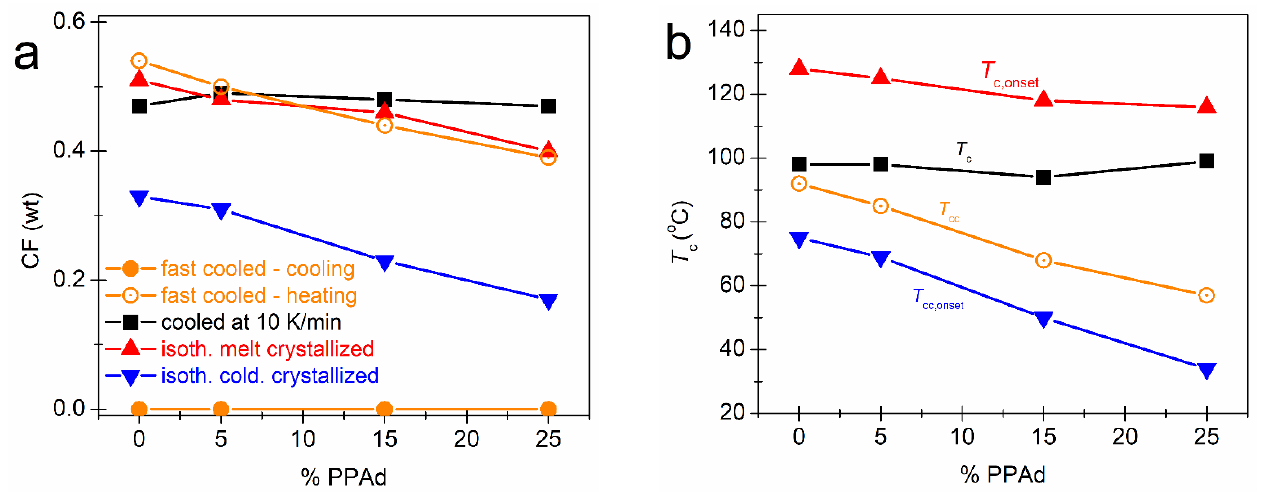
Figure 5. The PPAd content dependence of ( a ) the crystalline fraction and ( b ) crystallization temperatures (peaks or onsets), as evaluated from the various scans (thermal treatments) employed.